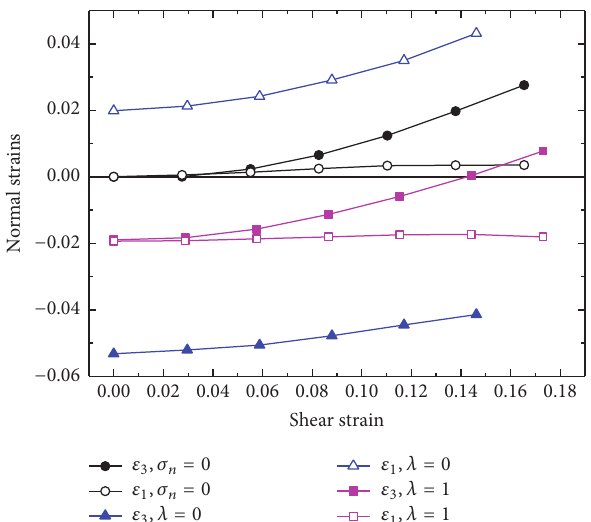
Figure 2: The ideal shear strength 𝜏 max as a function of the superimposed normal stress 𝜎 𝑛 for several values of the parameter 𝜆 .